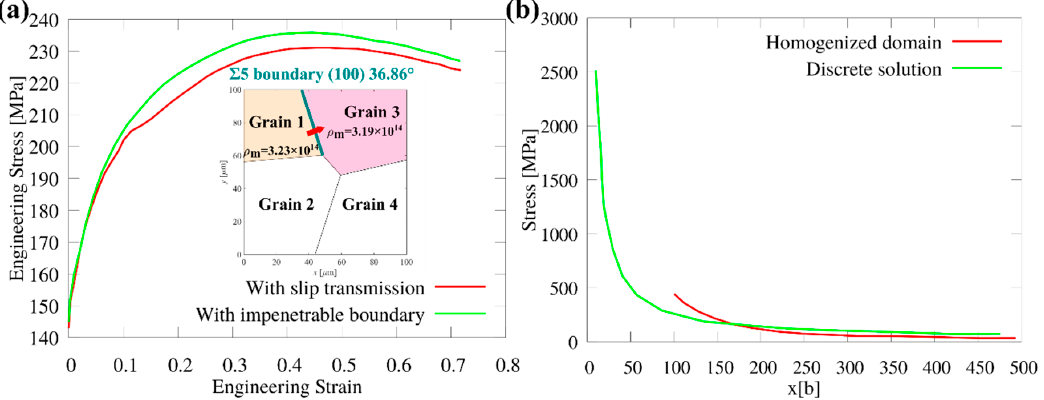
Figure 2. ( a ) Verification of the slip transmission model on a four-grain sample; ( b ) Verification of the back-stress model on a two-grain sample with a tilt grain